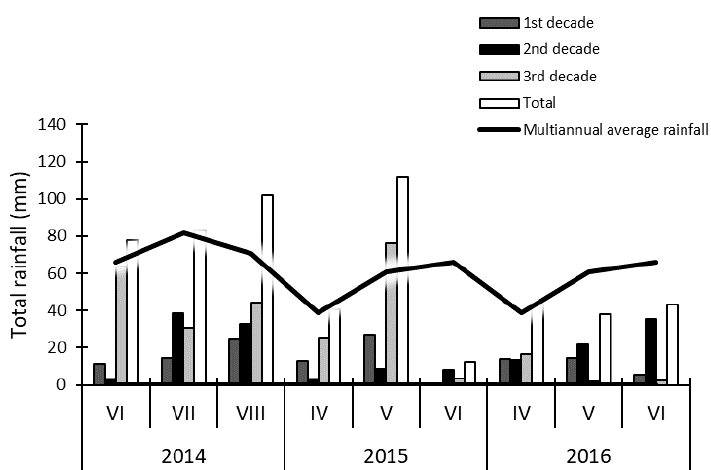
Figure 2. Mean air temperature during the vegetation of first crop alfalfa in the year of sowing (2014) and the production years (2015, 2016) in relation to the multiannual average.